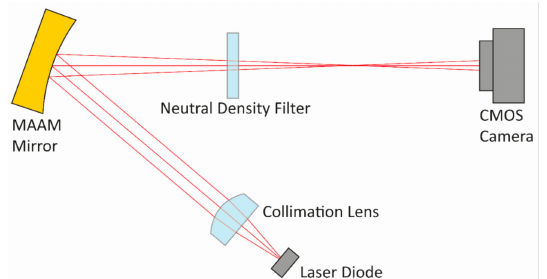
Figure 8. Schematic image of the MAAM mirror charaterization setup. A nearly collimated laser diode beam is reflected onto a complementary metal-oxide-semiconductor (CMOS) camera chip for beam profile characterization. The fast axis profile of the beam (within image plane) is modified by the mirror curvature. The slow axis profile of the beam (perpendicular to image plane, not shown here) remains unchanged by the MAAM